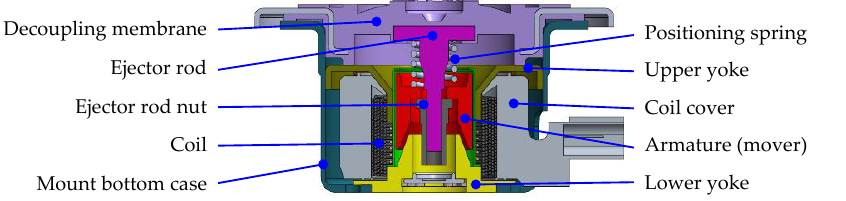
Figure 3. 3-D model for solenoid actuator.